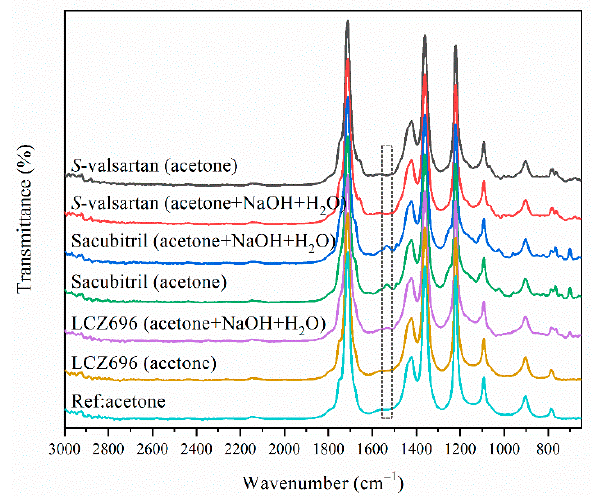
Figure 10. ATR-FTIR spectra of S -valsartan, sacubitril, and LCZ696 in acetone and acetone with sodium hydroxide aqueous solution.